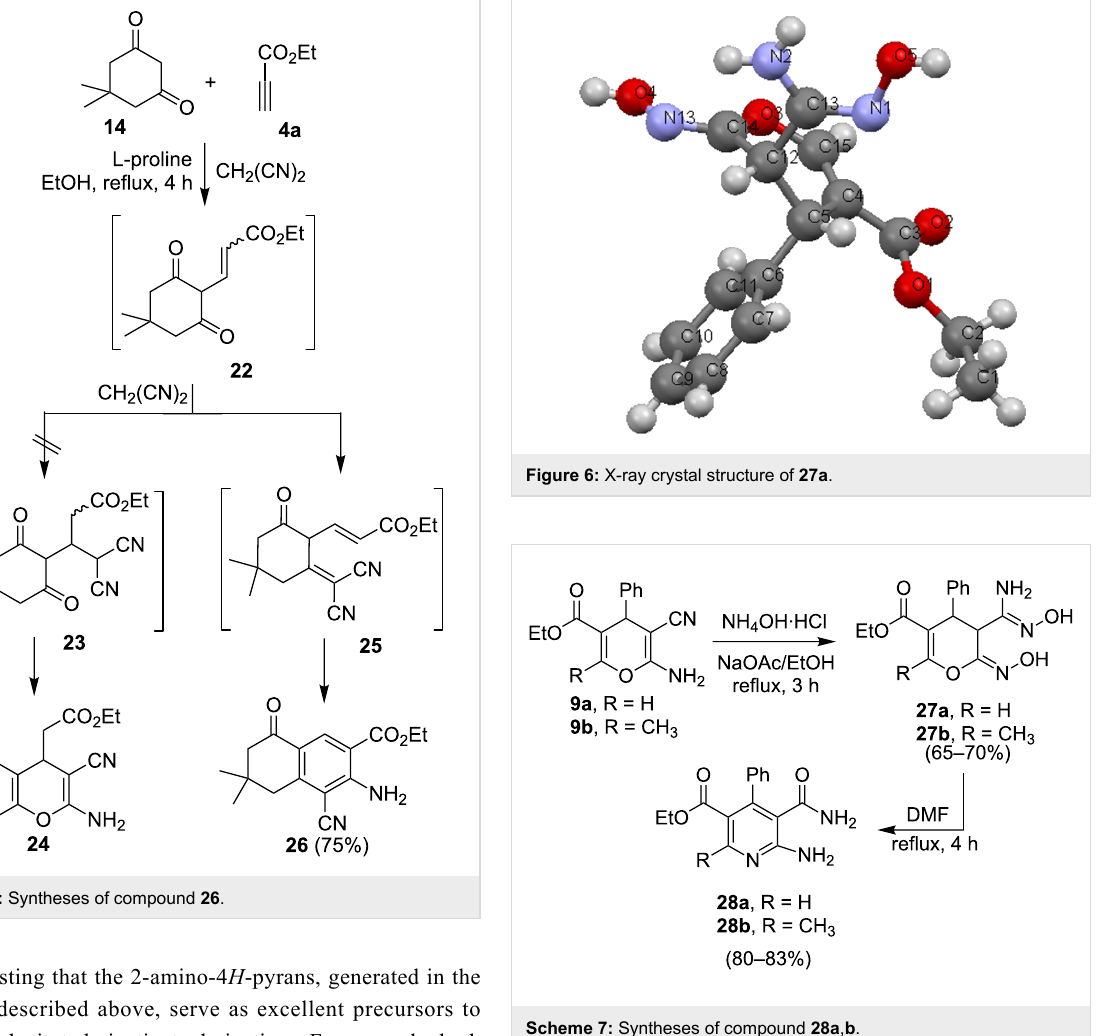
Scheme 7: Syntheses of compound 28a , b .